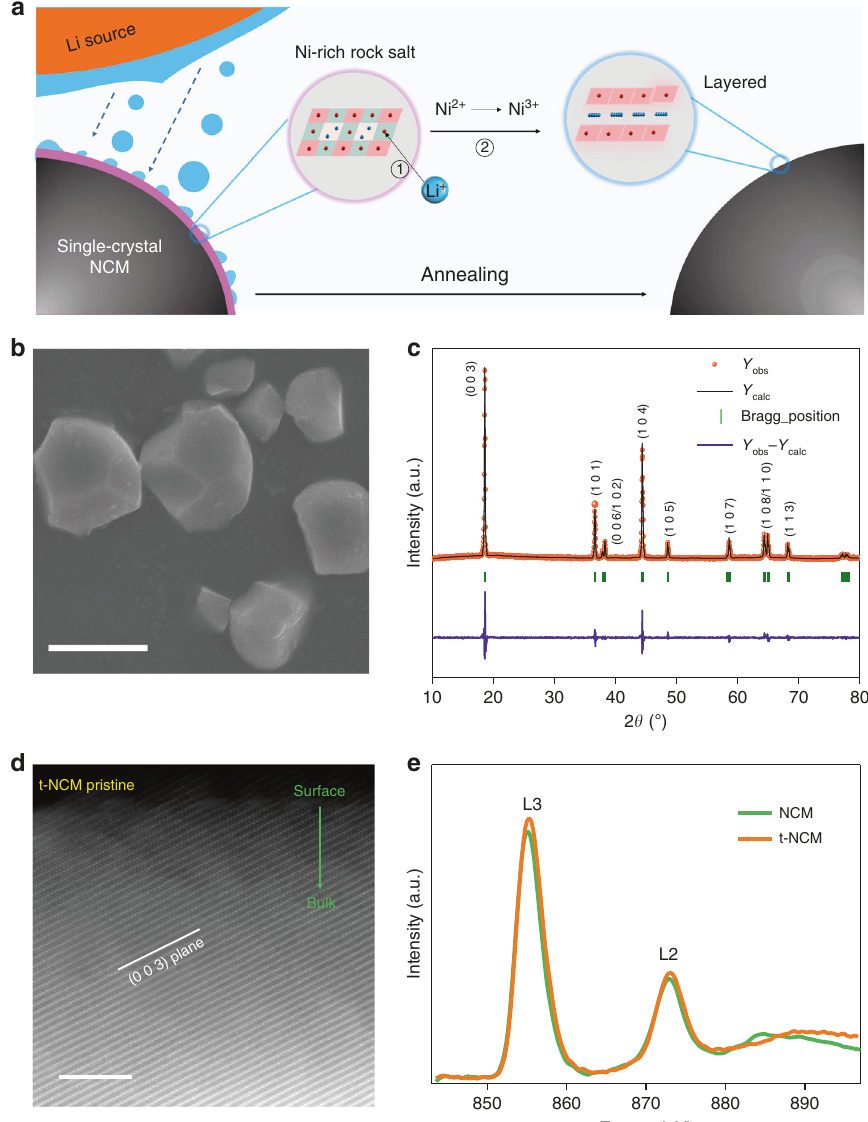
Fig. 7 Surface structure and morphology analysis of the t-NCM. a Diagram of the synthesis process and mechanism for modi fi ed NCM. b SEM image of pristine t-NCM. c XRD of pristine t-NCM d Atomic resolution HAADF-STEM images of pristine and cycled t-NCM samples. Scale bars 5 nm. e Soft XAS spectra of Ni L-edge for